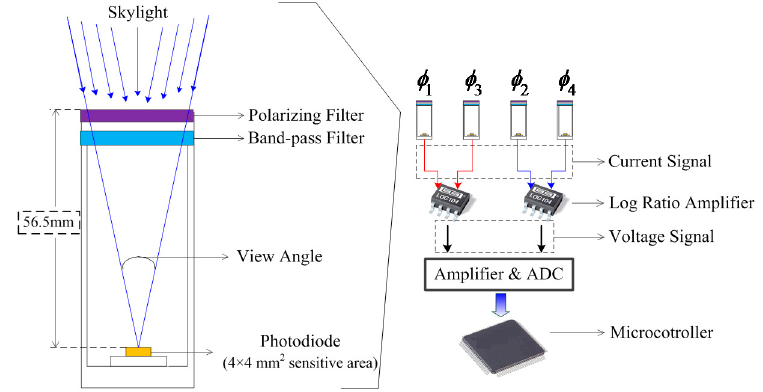
Figure 2. Left part: The sketch map of a single channel; Right part: The integral structure of the sensor. In Rayleigh scattering, the intensity of scattered light is inversely proportional to the biquadrate of the wavelength. So the blue light (short wavelength) usually dominates the skylight in the daytime, and that is why the sky looks blue. To further investigate the scattered light of clear sky, we took a spectral measurement of a certain clear sky area (without clouds or direct sunlight) using an analytical spectral device (ASD) manufactured by PANalytical Company (Boulder, CO, USA). The spectral radiance curve is shown in Figure 3. Although the spectral data may be variable in a different time, position and direction, the spectral features in Figure 3 are authentic. The intensity of skylight varies with incident direction. Generally speaking, the closer to the solar position, the brighter the skylight is. From Figure 3 we can find that the violet blue band has relatively high intensity which corresponds with the Rayleigh theory. So our sensor takes a 400–500 nm band-pass filter to choose the incident light band which is painted blue in Figure 3. Beside intensity, the selection of spectral range corresponds more or less to the spectral sensitivity of the polarization sensitive blue receptors in the POL area of crickets [5]. The violet blue sensitive photodiodes are chosen correspondingly, of which spectral responses are about 0.25 A/W in the chosen band. The chosen photodiodes are QY-S114QM manufactured by Qingyue Tech (Shanghai, China). The photodiodes increase current signal when receiving irradiation. The ideal response of a photodiode can be expressed as Equation